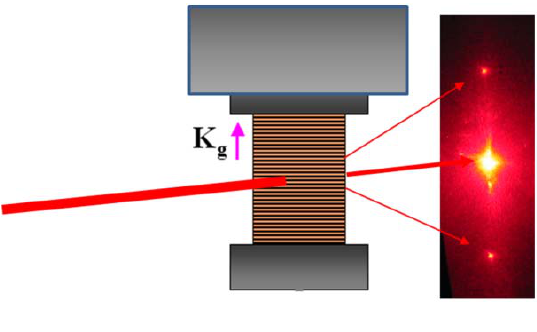
Figure 2. Schematic drawing of the experimental configuration: The sample (striped rectangle) is fixed at its upper edge while its lower edge is loaded with a small weight. On the right: Image of the far-field diffraction pattern of the probe beam. The ±1st order diffraction peaks are analyzed in the